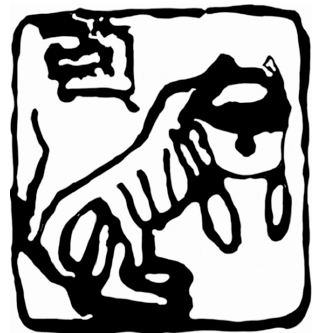
Figure 6. A Song Yuan Huaya with a Phagspa characters “Ji” and a tiger motif. The Yuan Dynasty. Inventory number: 0429. Sketched by author. Picture source: Wen (1995), p. 150.